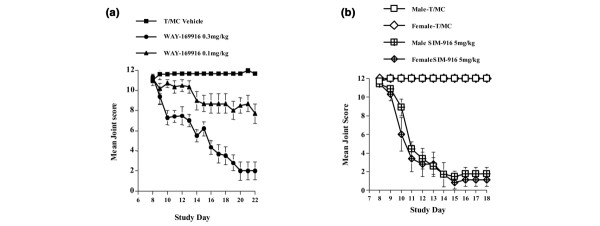
WAY-169916 improves joint scores in a dose-dependent fashion in rat adjuvant-induced arthritis model. (a) Male Lewis rats were injected with complete Freund's adjuvant on day 1 and maximal inflammation was allowed to develop. Beginning on day 8 and continuing until day 22, rats were treated daily with oral vehicle or WAY-169916 (0.3 and 0.1 mg/kg). Joint scores were assessed by evaluating hindpaws for erythema and swelling (0 to 3 each; maximal score of 12). (b) WAY-169916 improves joint scores in rat adjuvant-induced arthritis model in both males and females. Experiments were performed as in (a) except that WAY-169916 was dosed daily at 5 mg/kg orally in both intact male and intact female rats.